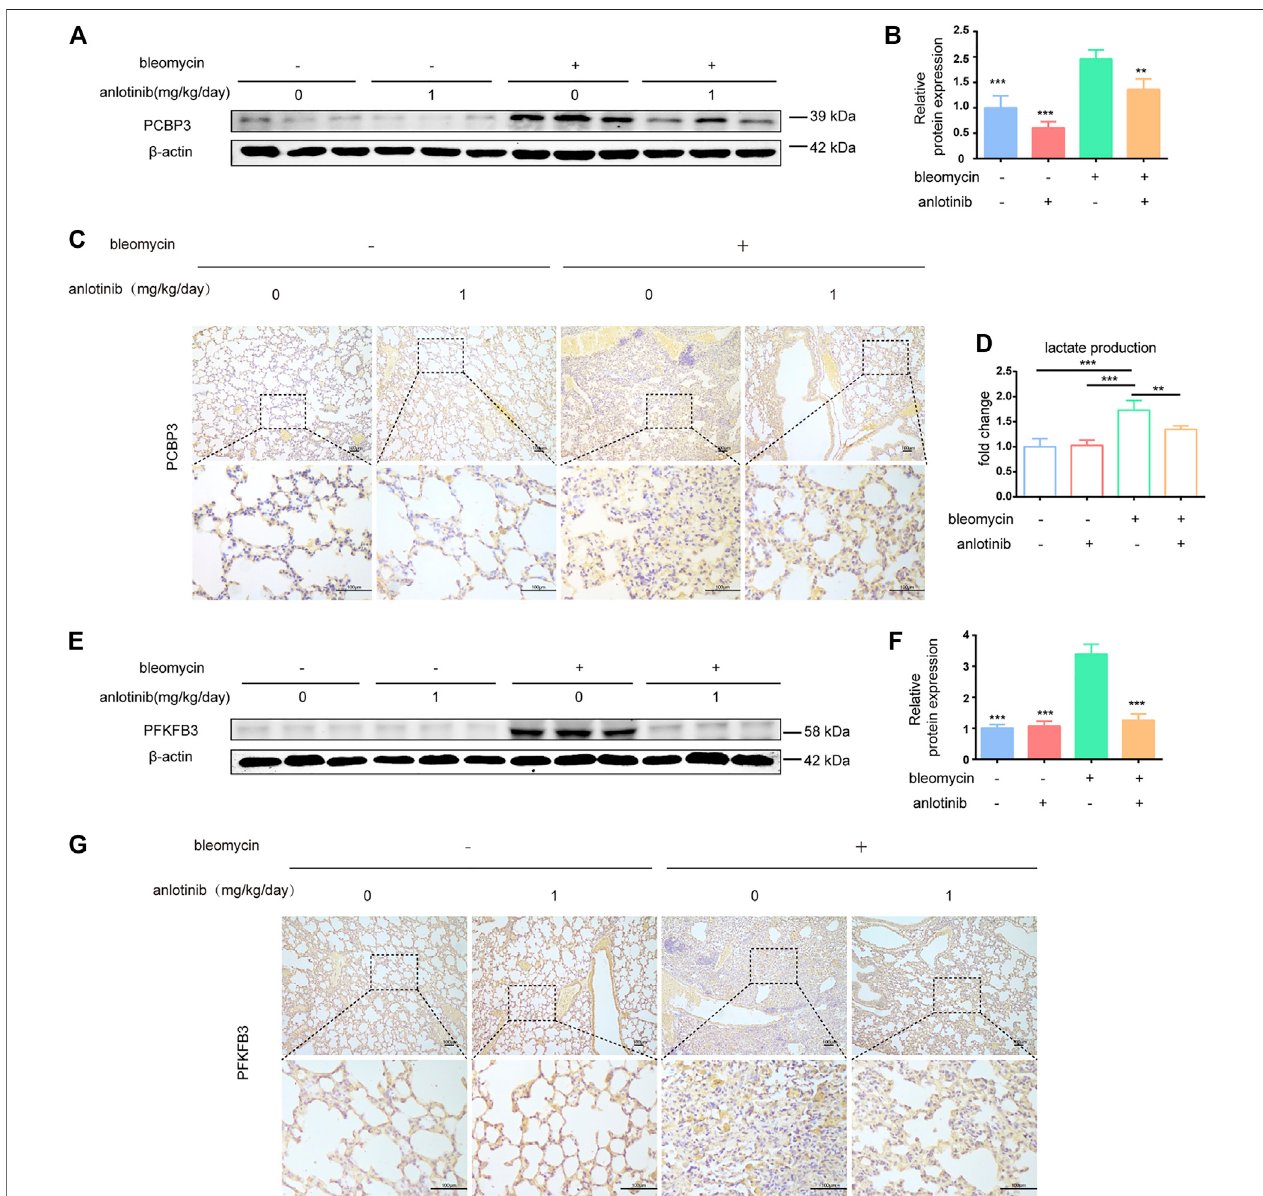
FIGURE 6 | Anlotinib decreases PCBP3 expression and inhibitthe PFKFB3-driven glycolysis in fi brotic rodent lungs. (A) Intervention dosing regimen of anlotinib in experimental mouse model of fi brosis. C57BL/6 mice were intraperitonealy injuected with 1 mg/kg of anlotinib or vehicle (n (cid:1) 5-6 per group) daily after bleomycin instillation. Lungs were harvested at 21 days. Western blot analysis of PCBP3, β -actin was used as a loading control (n (cid:1) 6). (B) Quanti fi cation of PCBP3 protein levels relative to β -actin is shown (mean ± SD, n (cid:1) 6). (C) Representative images show PCBP3 staining of lung sections from the indicated groups of mice. Scale bars, 100 µm. (D) lactate contents in lung tissues from mice (mean ± SD, n (cid:1) 5). (E) Western blot analysis of PFKFB3, β -actin was used as a loading control (n (cid:1) 6). (F) Quanti fi cation of PFKFB3 protein levels relative to β -actin is shown (mean ± SD, n (cid:1) 6). (G) Representative images show PFKFB3 staining of lung sections from the indicated groups of mice. Scale bars, 100µm. ** p < 0.01, *** p < 0.001 VS BLM-treated group by one-way ANOVA.